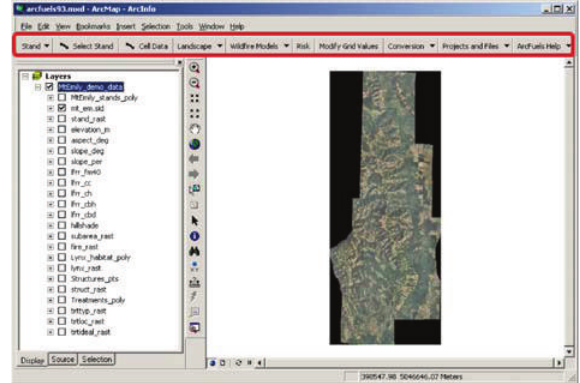
Figure 4: ArcFuels appears as a toolbar (outlined in red) on top of the ArcMap window. For functionality of the di ff erent buttons see Table